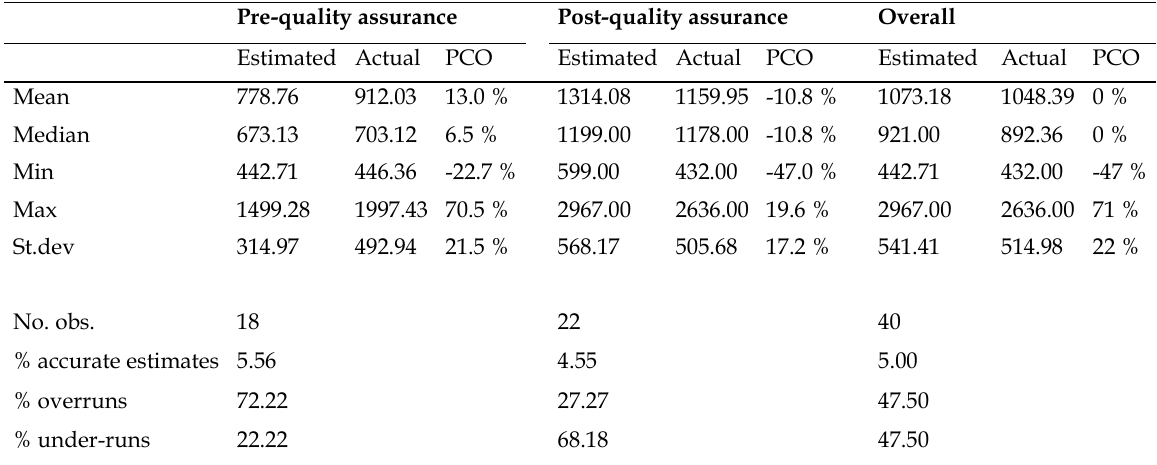
Table 1. Summary